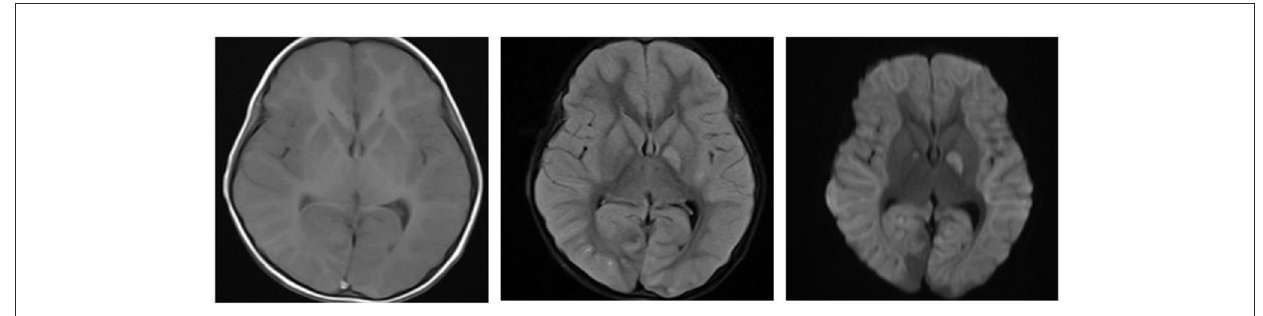
FIGURE4 Cranial MRI on 10th